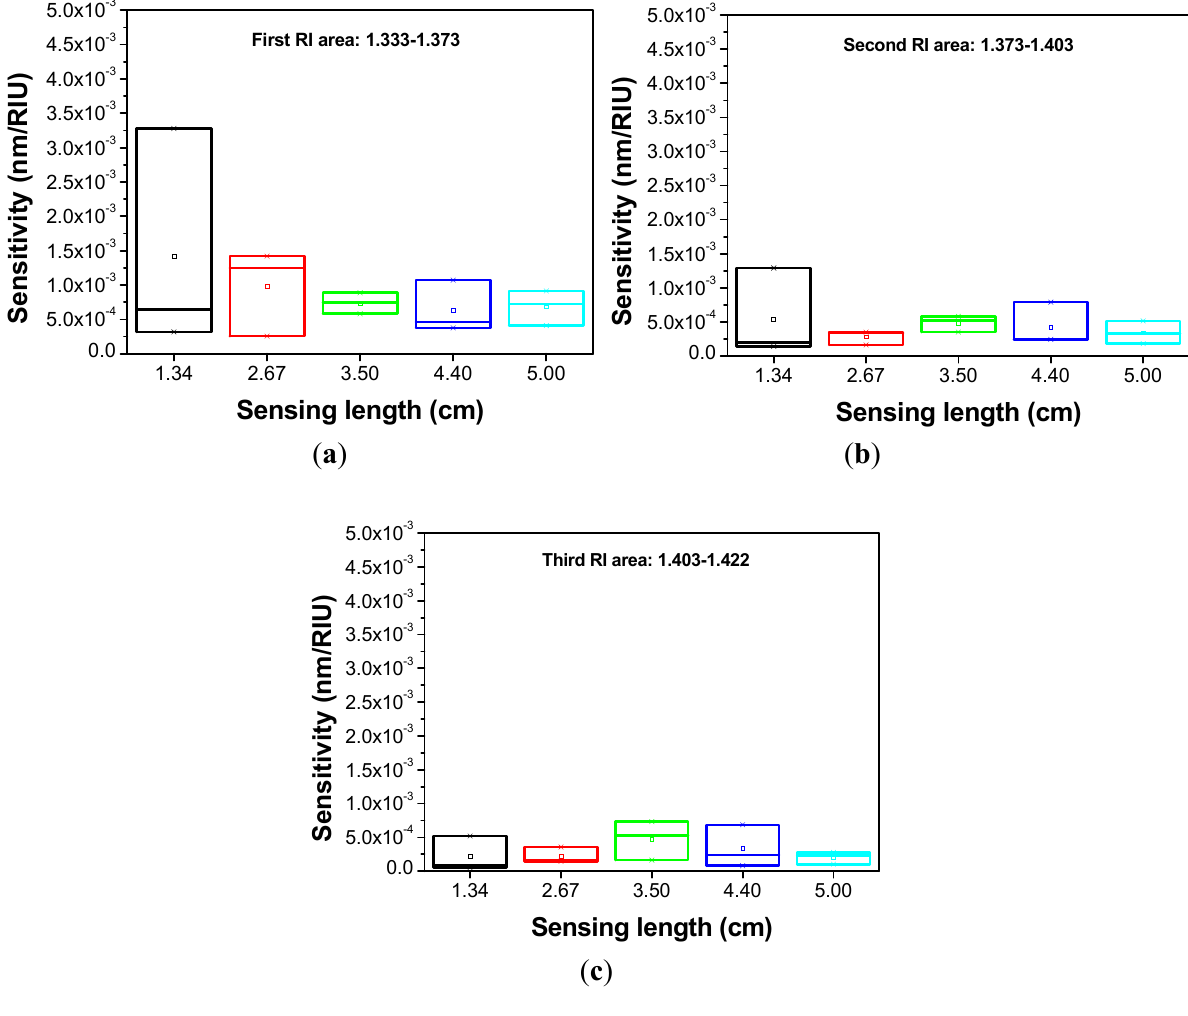
Figure 13. Plot of the relationship between sensitivity and sensing length for PCF interferometer at ( a ) first refractive index area (RI = 1.333 − 1.370); ( b ) second